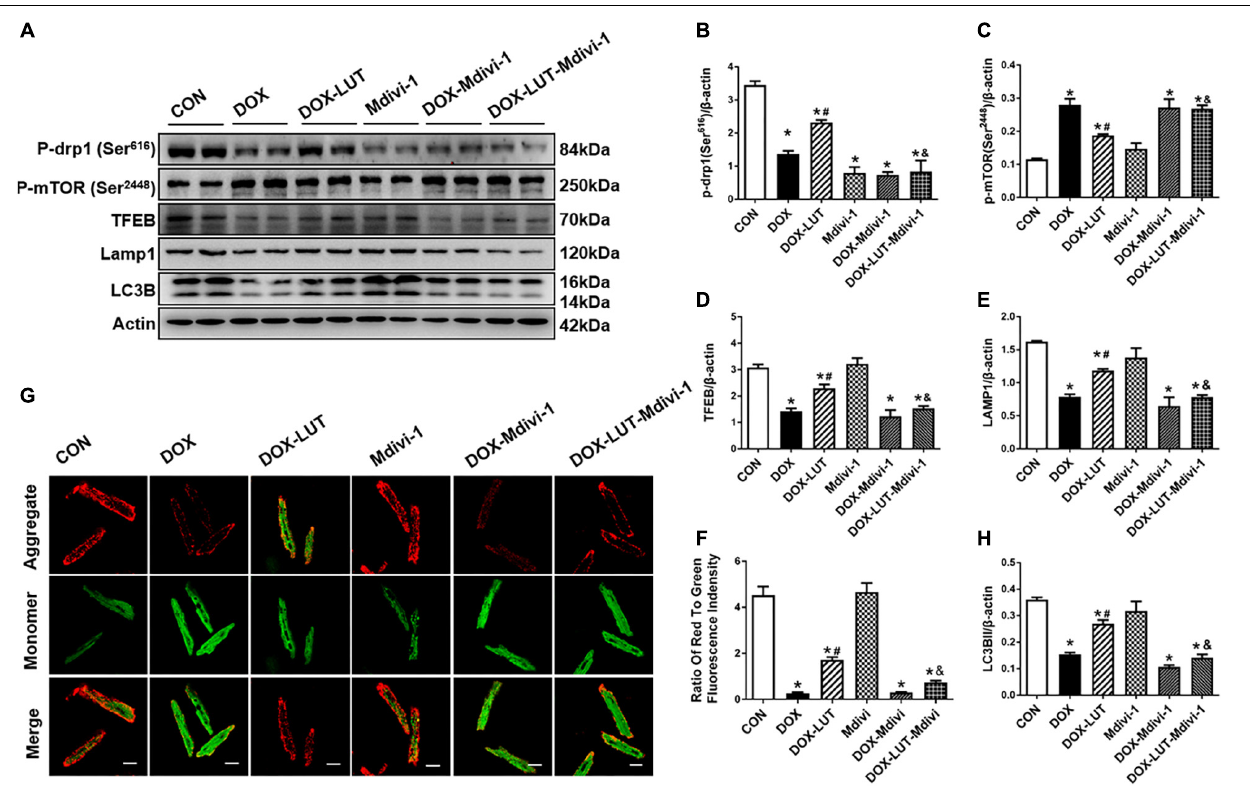
FIGURE 6 | Treatment of Mdivi-1, a Drp1 GTPase inhibitor, on luteolin-offered benefit against doxorubicin-induced cardiotoxicity. (A) Representative Western blot of p-Drp1 (Ser 616 ), p-mTOR (Ser 2448 ), TFEB, LAMP1, and LC3B. (B) Quantitative data of p-Drp1 (Ser 616 ); (C) p-mTOR (Ser 2448 ); (D) LAMP1; (E) TFEB; (F) LC3B; and (G,H) : Representative fluorescence images and quantitative analysis of cardiomyocyte (cid:49) ψ m using JC-1 fluorescence following mdivi-1 treatment from nine fields. Mean ± SEM, n = 3 independent experiments in duplicates per group. Scale bars = 25 µ m. * p < 0.05 vs. CON group, # p < 0.05 vs. DOX group, & p < 0.05 vs. DOX-LUT